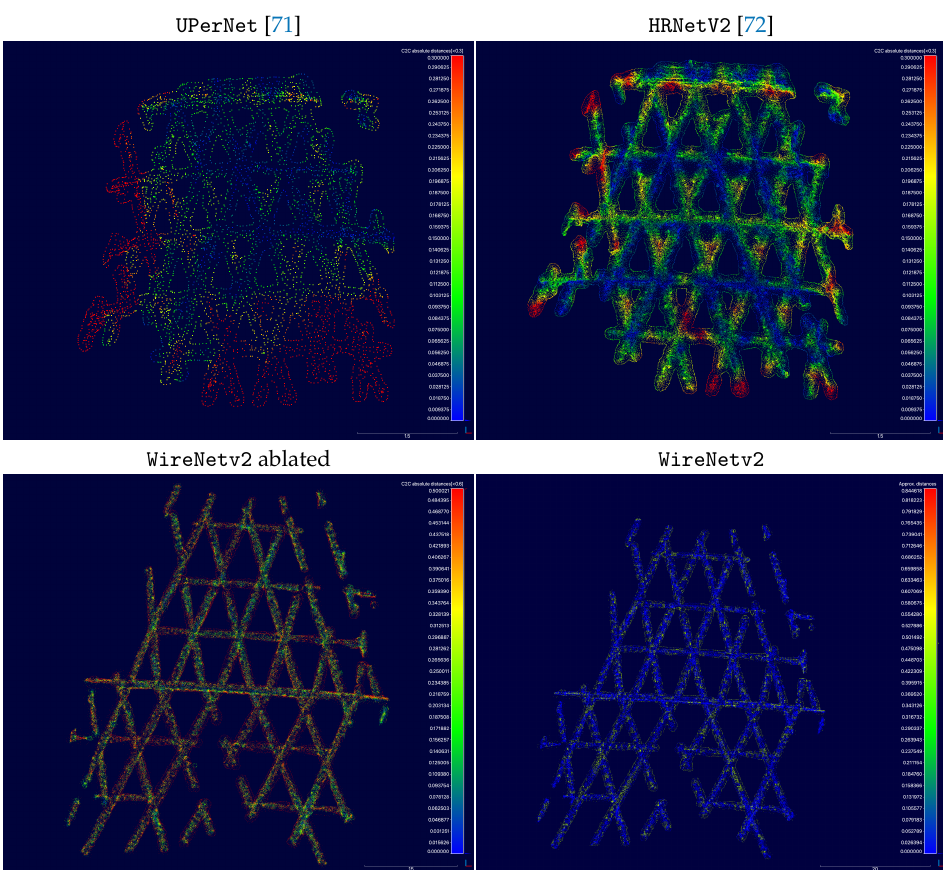
Figure 14. Comparison of the accuracy (in meters) of the final point clouds with respect to various accuracy of object masks provided by UPerNet [71], HRNetV2 [72], and the WireNetV2 model in the ablated and full versions. All point clouds were obtained from a series of ten photos of the II level of the tower.